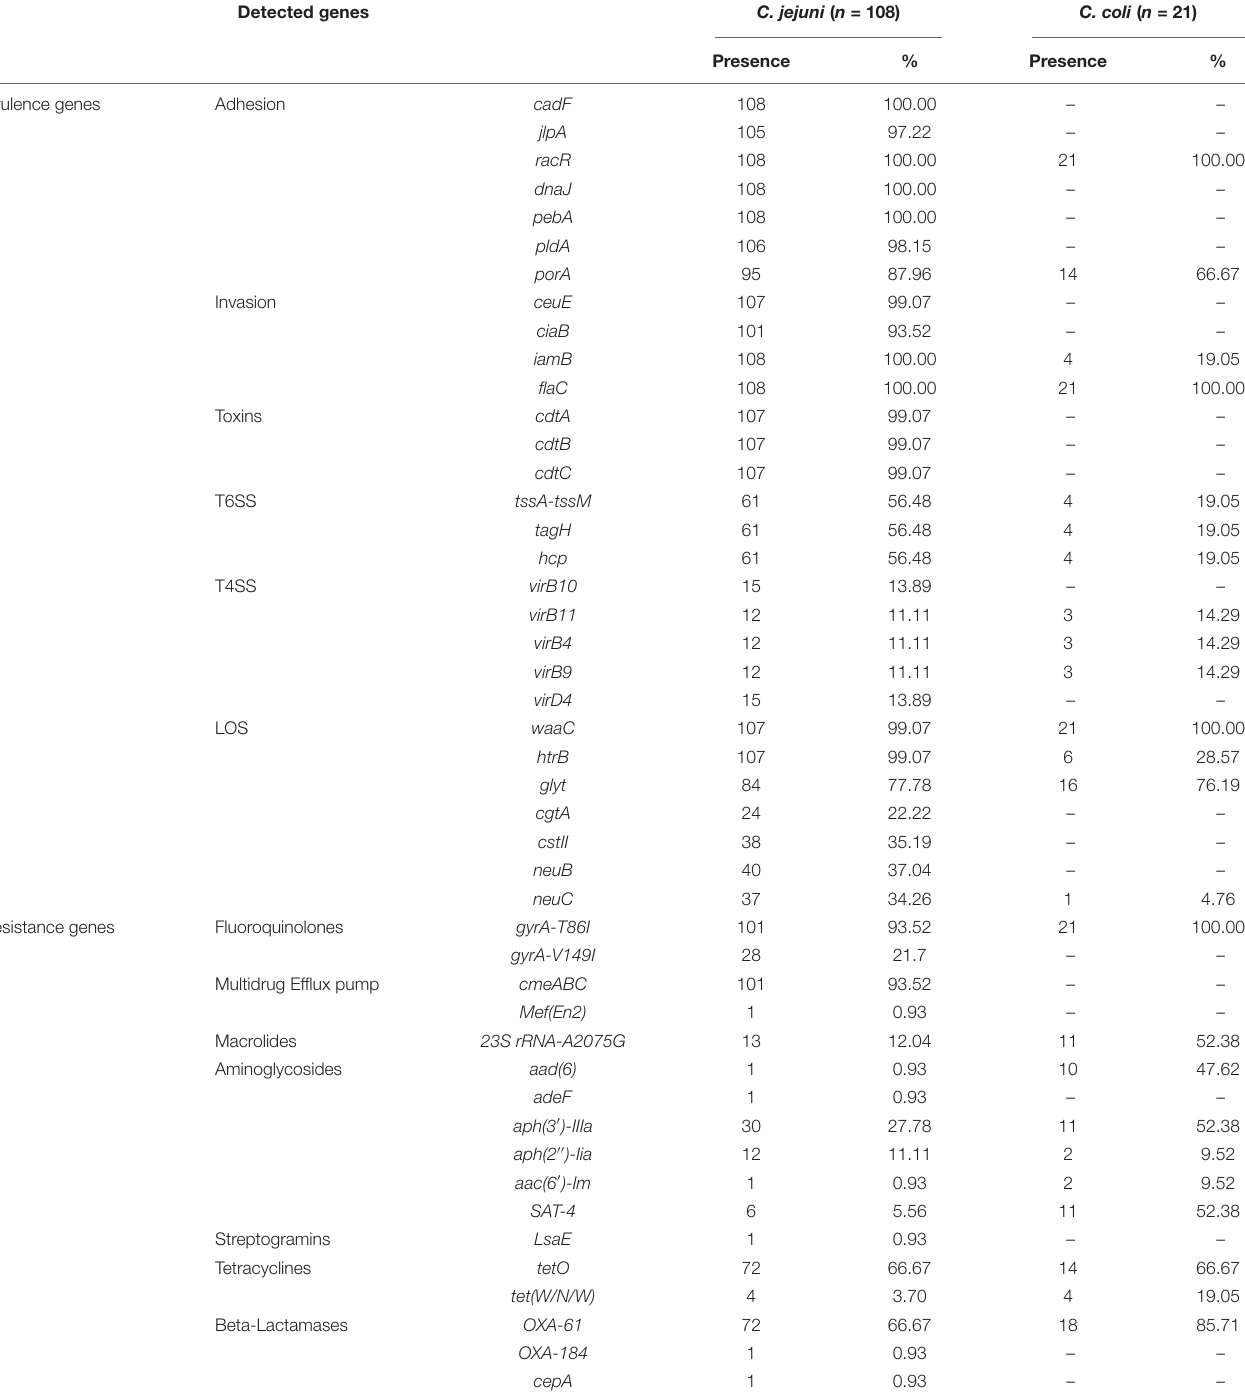
TABLE 3 | Detection of virulence and resistance genes in Campylobacter strains ( n = 129) according to the studied